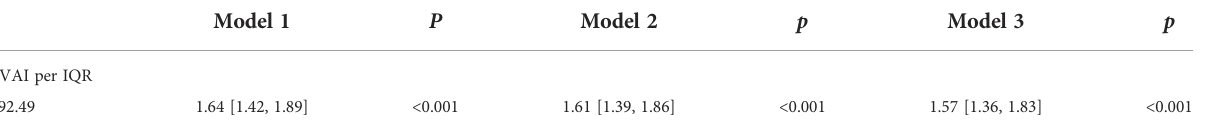
TABLE 3 Associations of CVAI with the risk of T2DM using piecewise logistic regression.